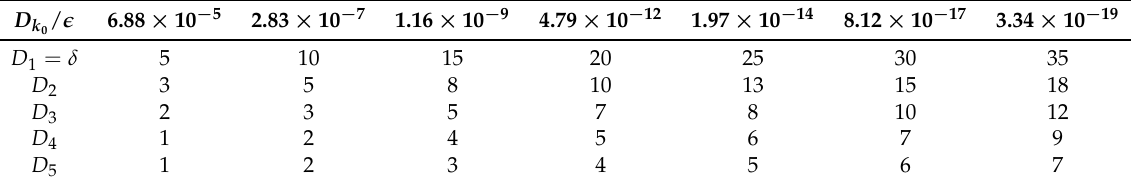
Table 2. Subdivision depth of 2-point approximating ternary subdivision curves.